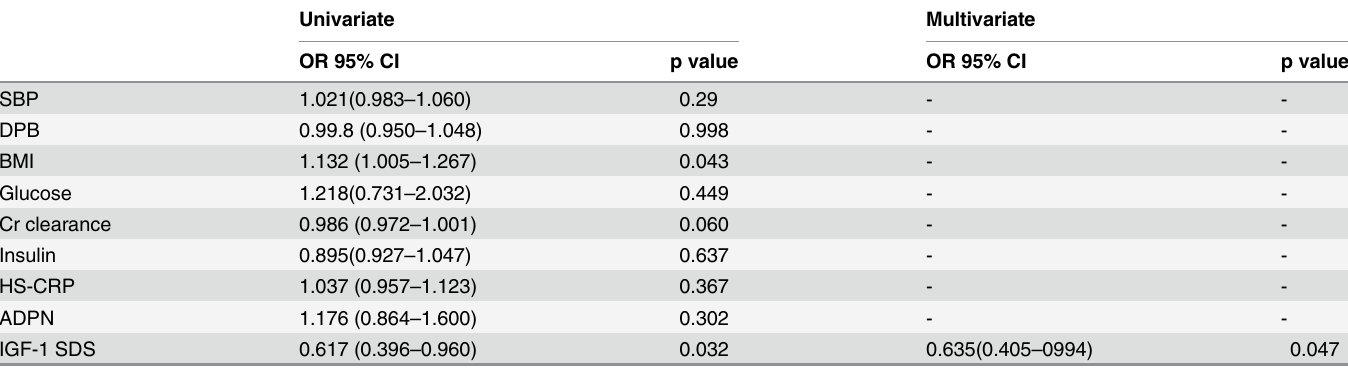
Table 4. Logistic regression model for the presence of a glomerular